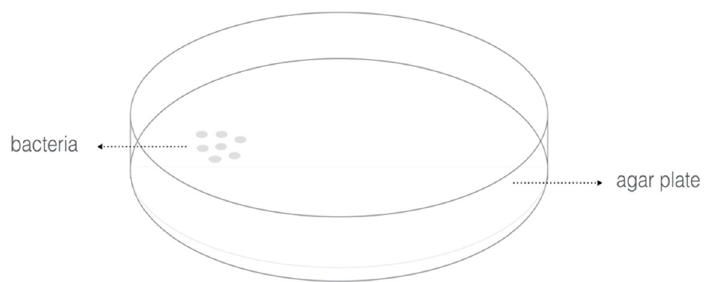
Figure 2. Agar plate.